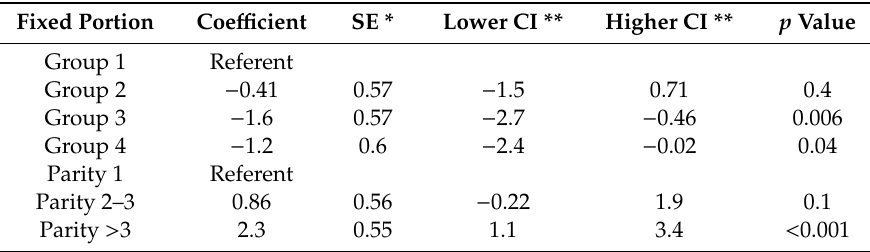
Table 3. E ff ect of treatment and parity at breeding on total litter